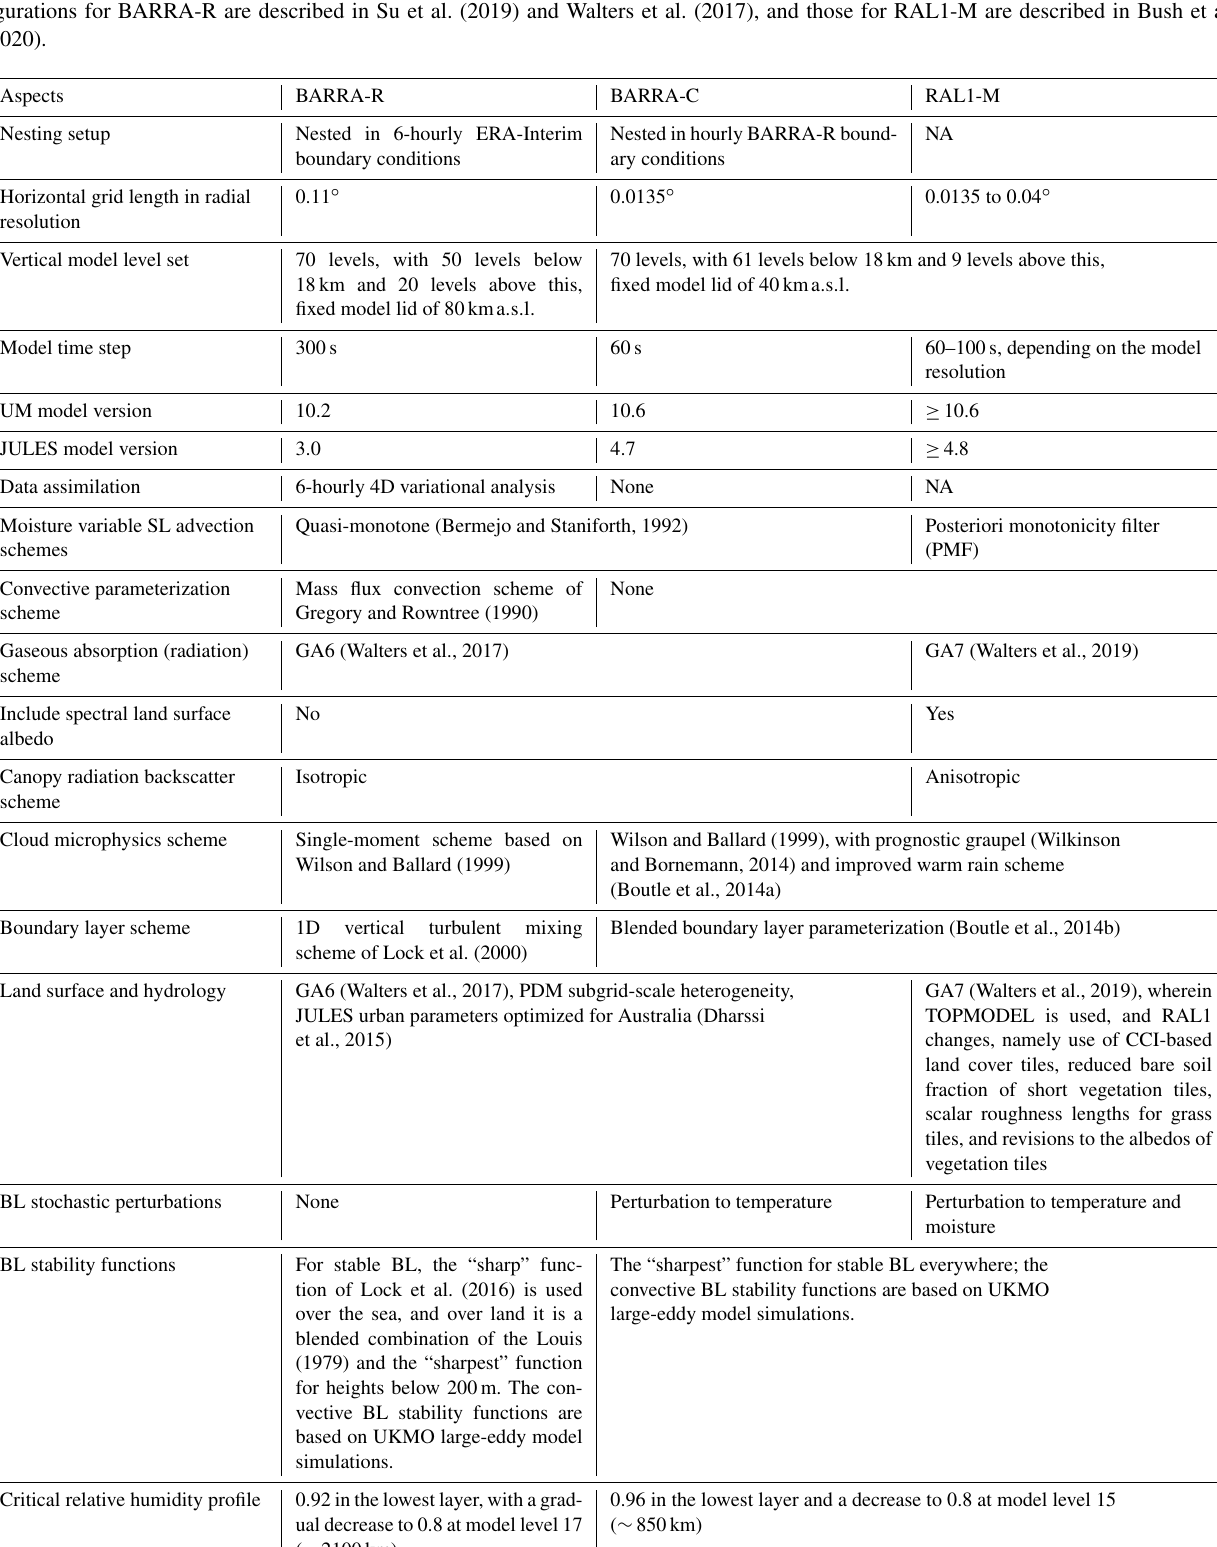
Table 1. An overview of major differences between BARRA-C, BARRA-R, and the midlatitude version of RAL1 (RAL1-M). The con- figurations for BARRA-R are described in Su et al. (2019) and Walters et al. (2017), and those for RAL1-M are described in Bush et al.